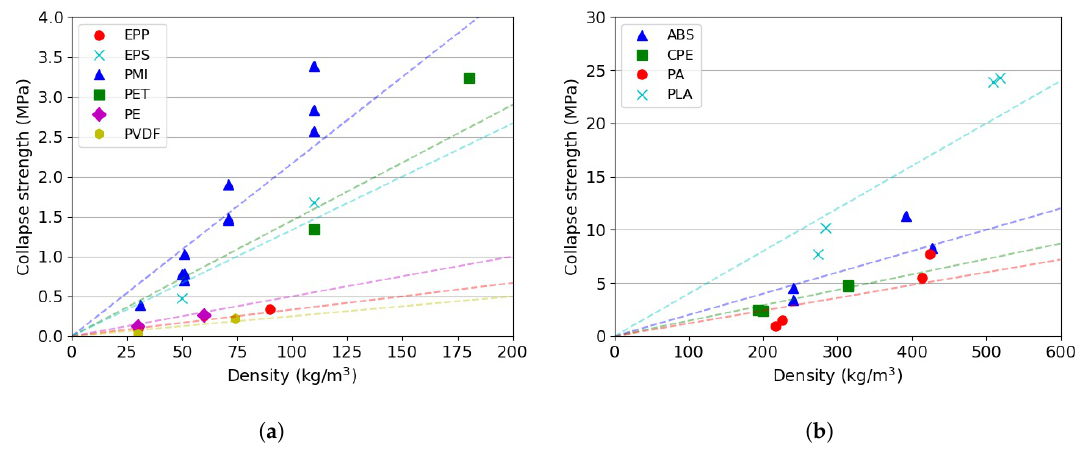
Figure 9. Collapse strength vs. density for the investigated materials (data from 2 mm/min compression tests). ( a ) Foams; ( b ) 3D